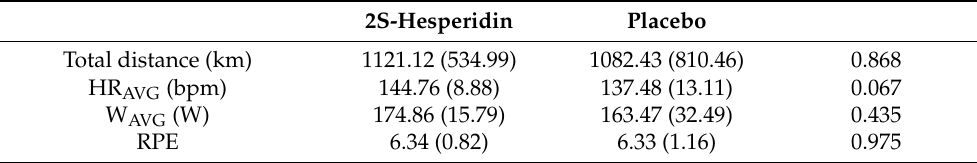
Table 2. Training variables of the cyclists.